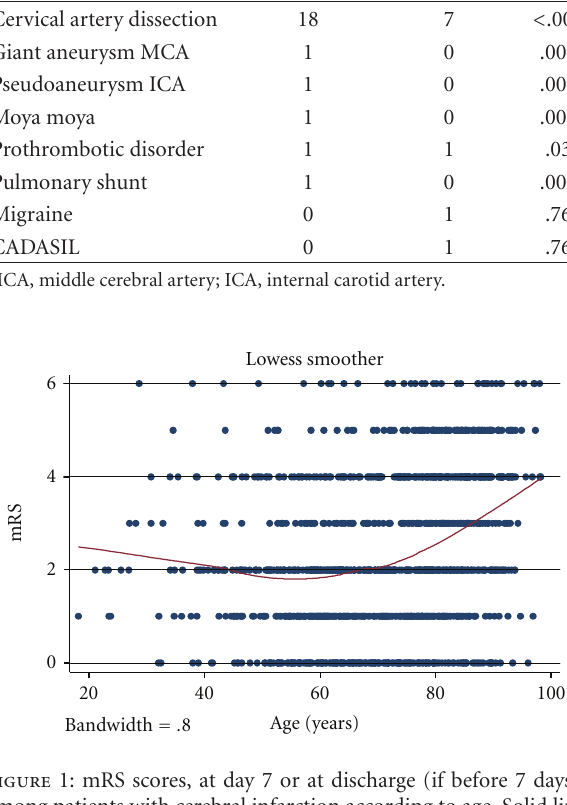
Figure 1: mRS scores, at day 7 or at discharge (if before 7 days), among patients with cerebral infarction according to age. Solid line shows mean mRS. mRS, modified Rankin